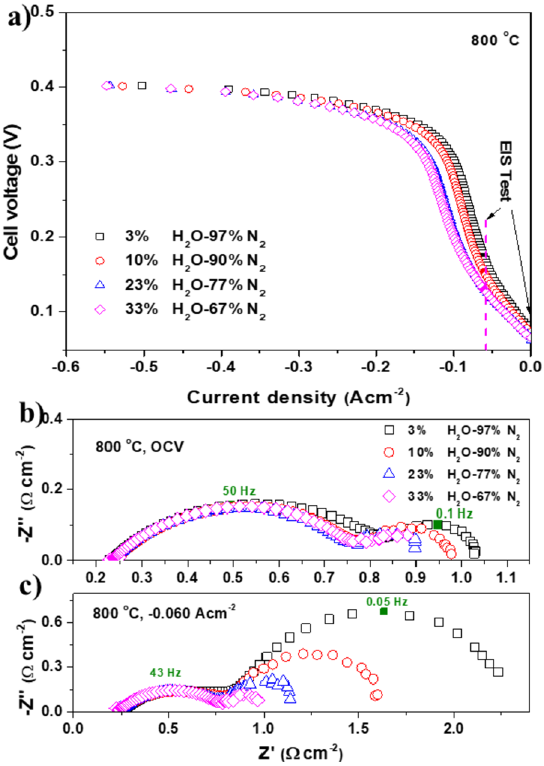
Fig. 3 a i-V curves and EIS measured at b OCV, and c − 0.060 A/ cm 2 conditions at 800 °C for symmetrical cell with a cell configura- tion of SFM-SDC/LSGM/SFM-SDC operated at different cathode